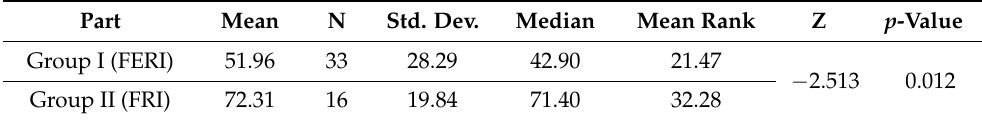
Table 3. Comprehension correctness of the first test (Mann–Whitney test).